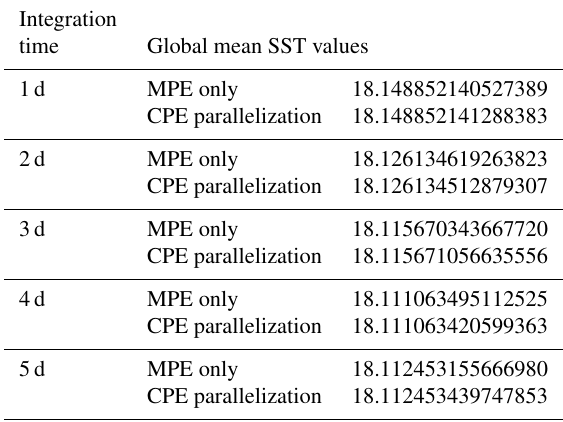
Table 8. Movement of the difference of global mean SST in digits caused by CPE parallelization by the forwarding of POP2 integra-